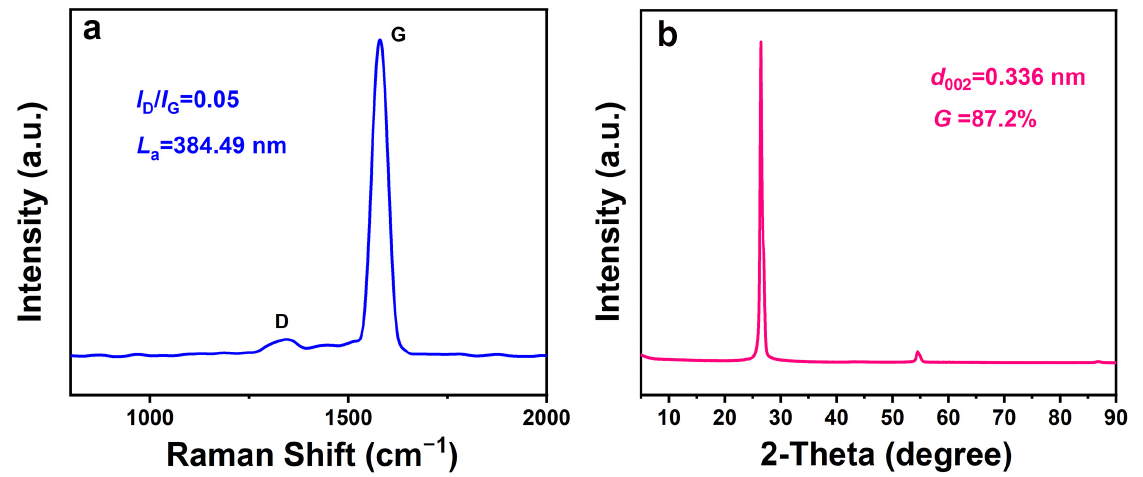
Figure 5. ( a ) Raman spectrum, ( b ) XRD patterns of